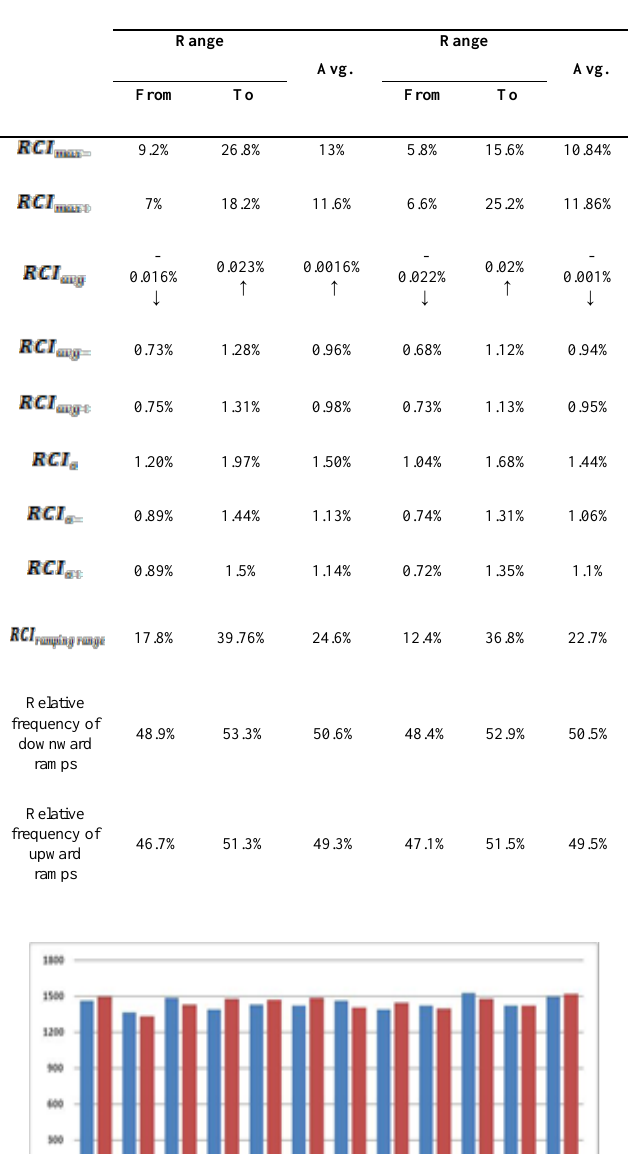
Table 4 . Horizontal analysis results by RCI